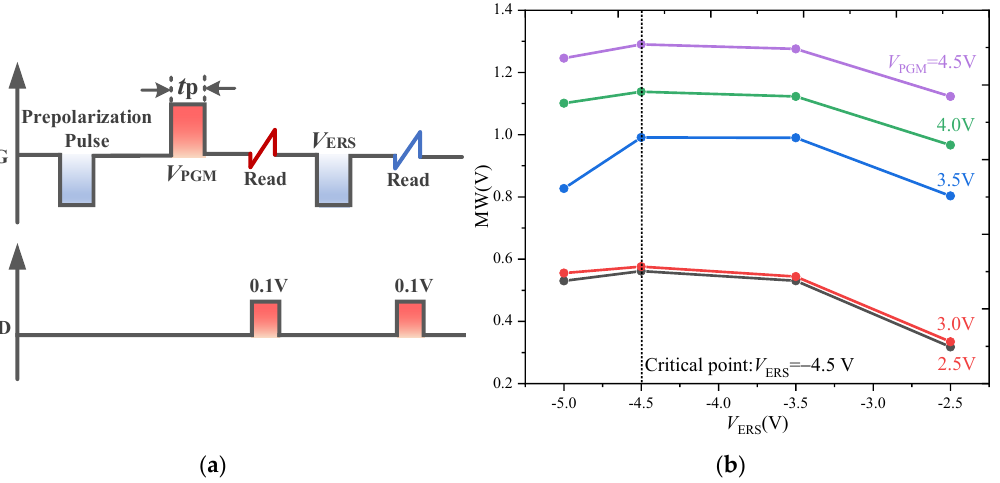
Figure 5. ( a ) Pulse sequence used for MW test at various V PGM of the FeFET. ( b ) Variation of MW with respect to V ERS for various values of V PGM in FeFET.